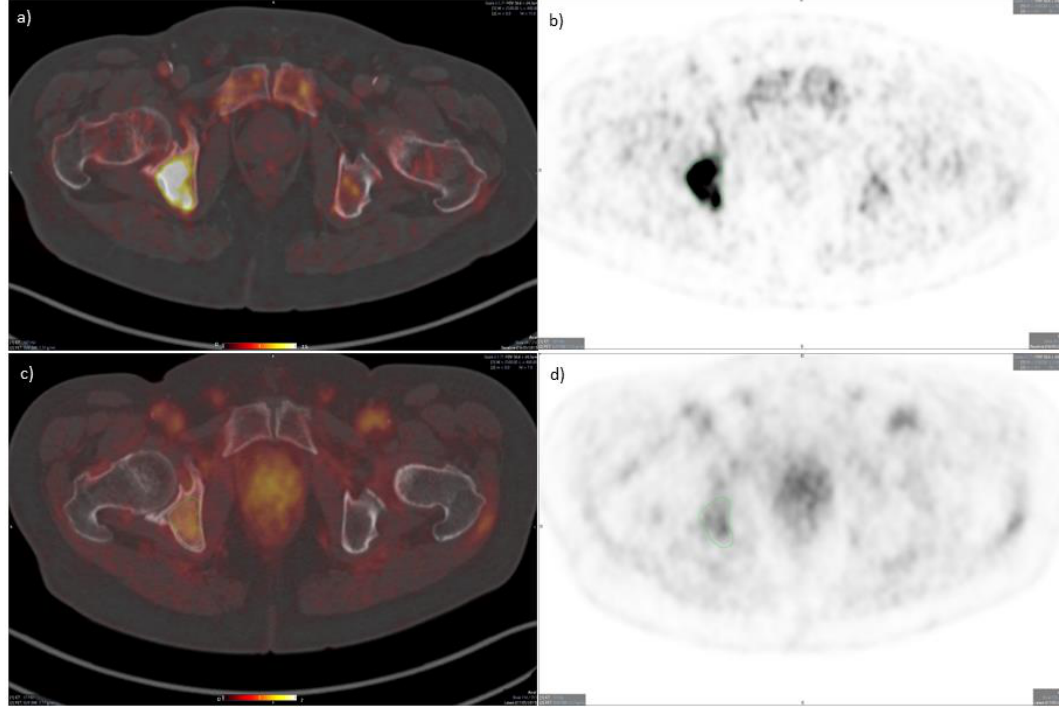
Figure 2. 18 F-fluoride and uPAR-PET/CT (patient 3) Transaxial fused images (left), PET images (right). ( a , b ): 18 F-fluoride PET/CT. ( c , d ): uPAR-PET/CT (bottom row). Bone metastasis in the pelvis is delineated. uPAR PET SUVmax = 2.9.